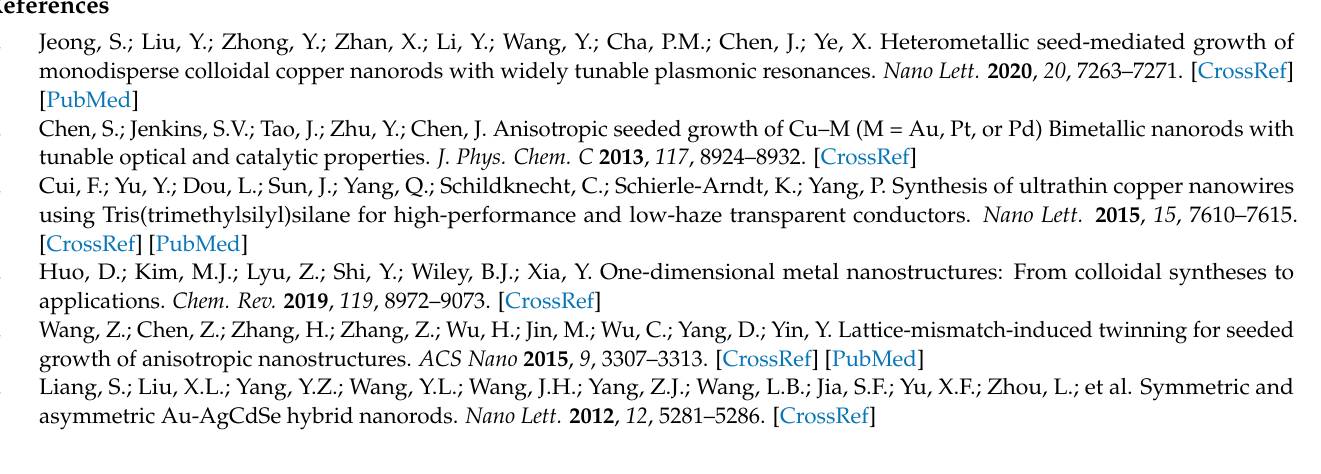
image of Au seeds, Figure S2: XRD pattern analysis of Cu/Cu 2 − x S NRs, Figure S3: absorption spectra of MO photocatalytic degradation, Figure S4: curve fitting for the plot of ln( C t / C 0 ) vs. time, Figure S5: influence of radical scavengers on the MO degradation, Figure S6: sample photograph after MO degradation, Figure S7: absorption spectra of MO photocatalytic degradation with scavengers, Figure S8: photocatalytic degradation of MB